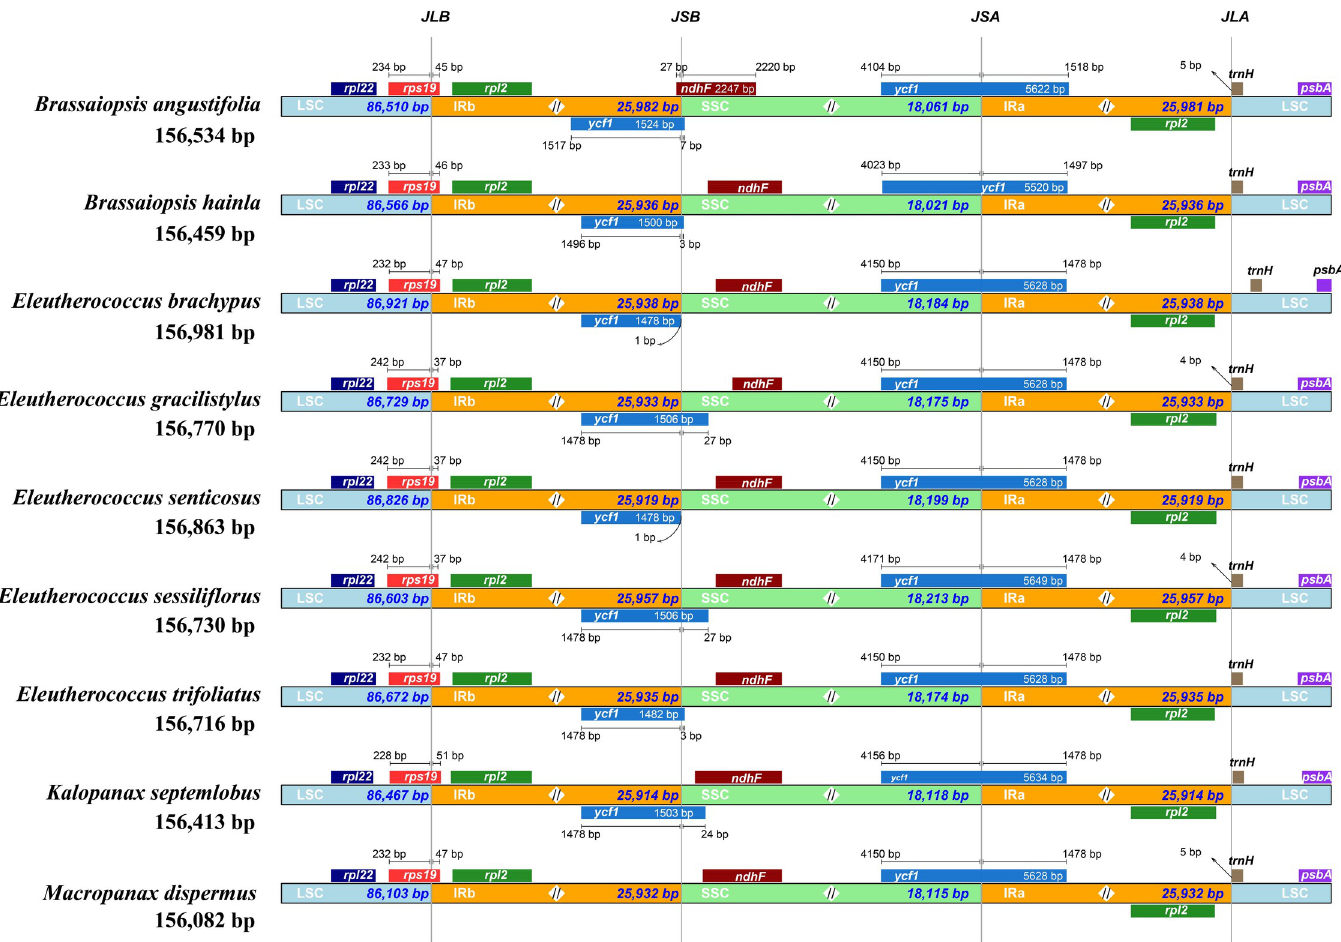
Fig 6. Comparison of the borders of the inverted repeat (IR), small single copy (SSC), and large single copy (LSC) regions among nine chloroplast genomes of the Asian Palmate group. JLB, JSB, JSA, and JLA represent the junctions of LSC/IRb, IRb/SSC, SSC/IRa, and IRa/LSC, respectively. The Fig is not drawn to scale based on sequence length but shows only the relative change near or at the IR/SC